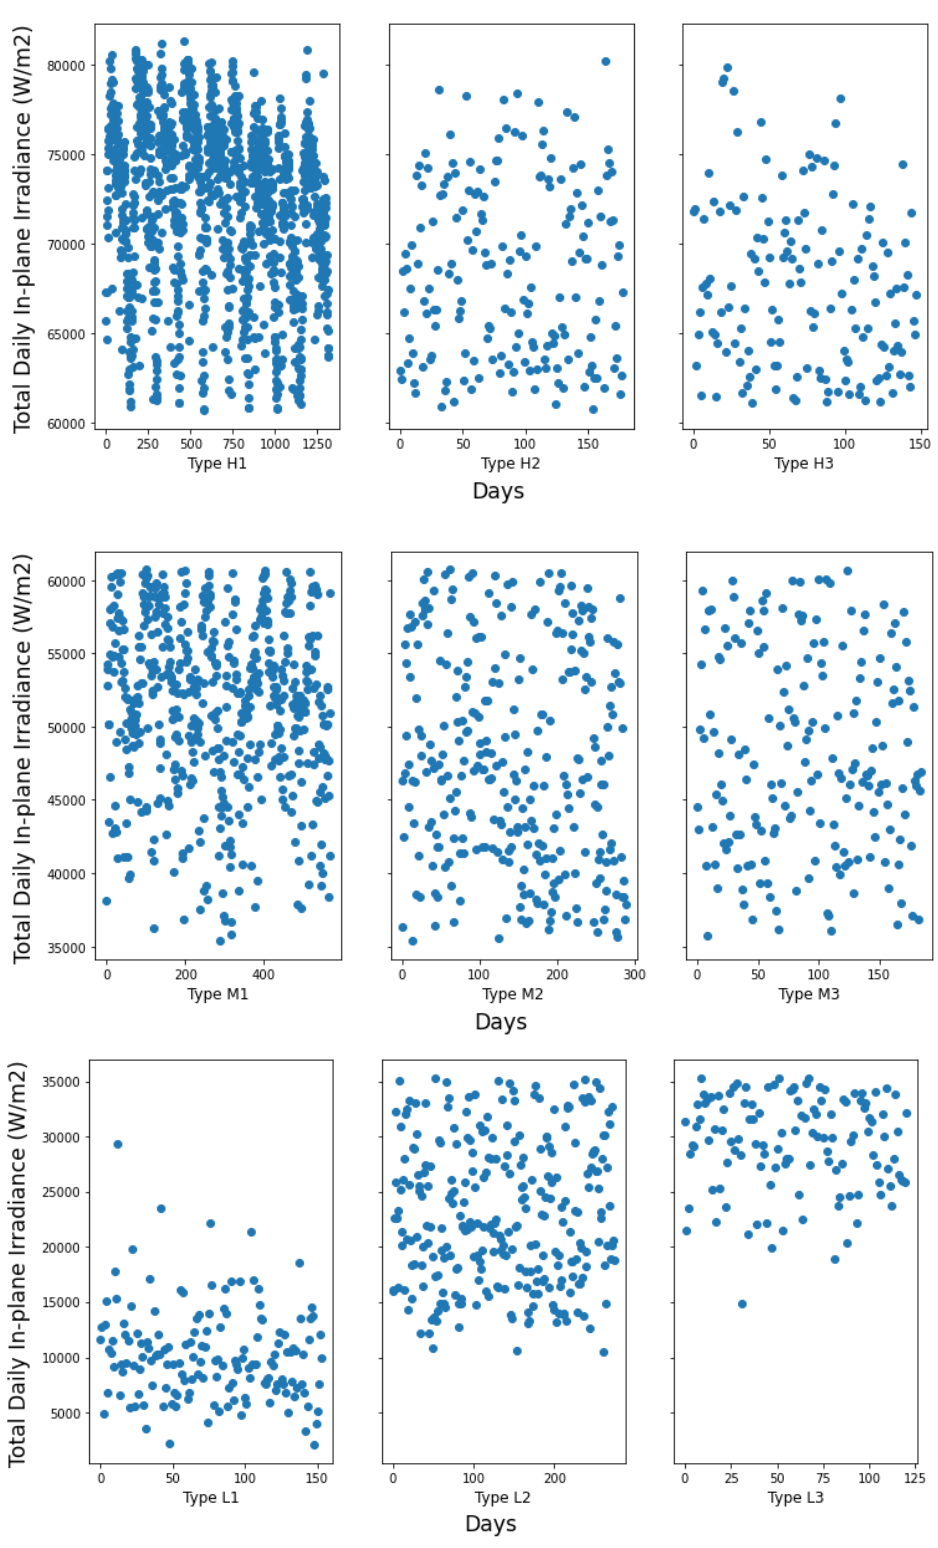
Figure 8. Centroids of the daily irradiance profiles obtained in the clusters L1, L2, L3, M1, M2, M3, H1, H2 and H3.